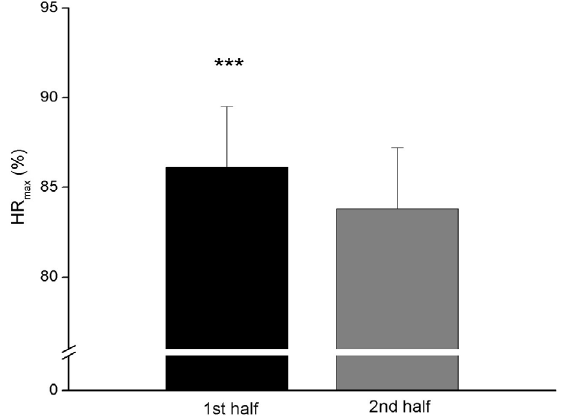
Figure 1. Player internal load (PIL) expressed as percentage of individual maximal or peak heart rate during official match-plays in youth soccer players (n=21). Data are presented as mean ±